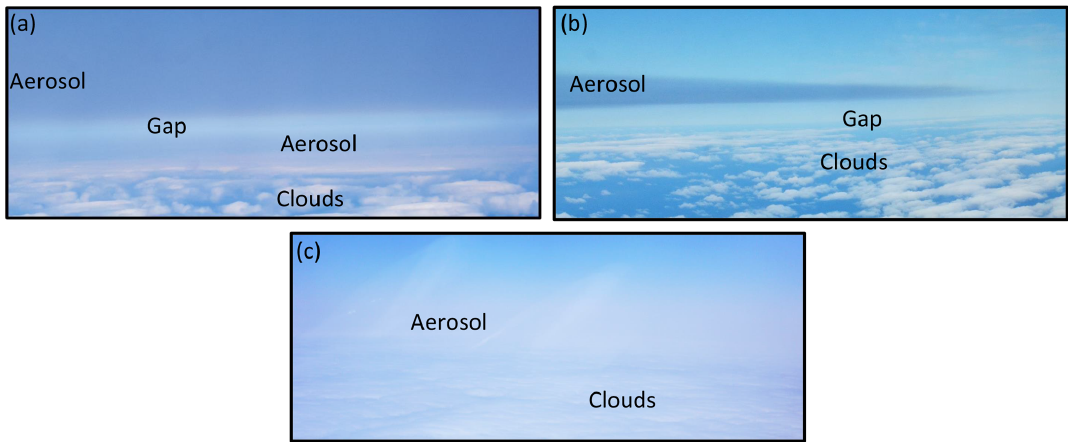
Figure 2. Photographs taken from the P-3 of (a) a gap between two aerosol layers, (b) a gap between an aerosol layer and cloud, and (c) no gap between aerosol and cloud.